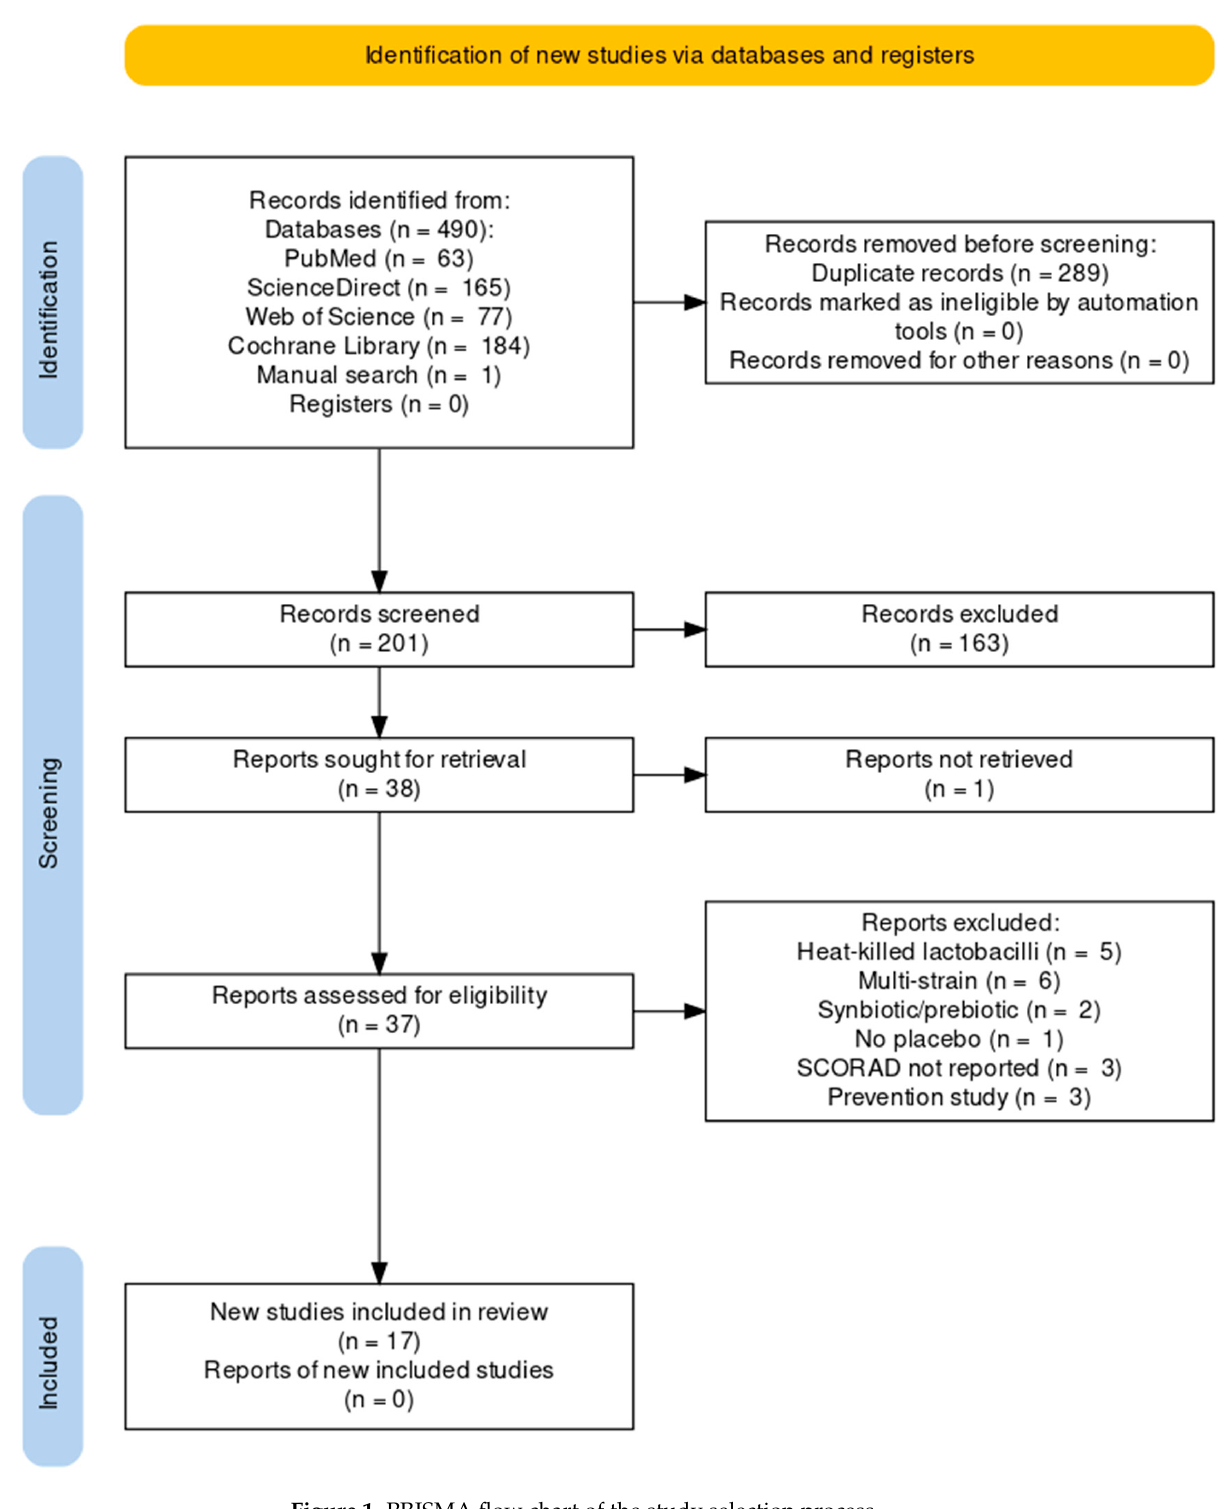
Figure 1. PRISMA fl ow chart of the study selection process. Figure 1. PRISMA flow chart of the study selection